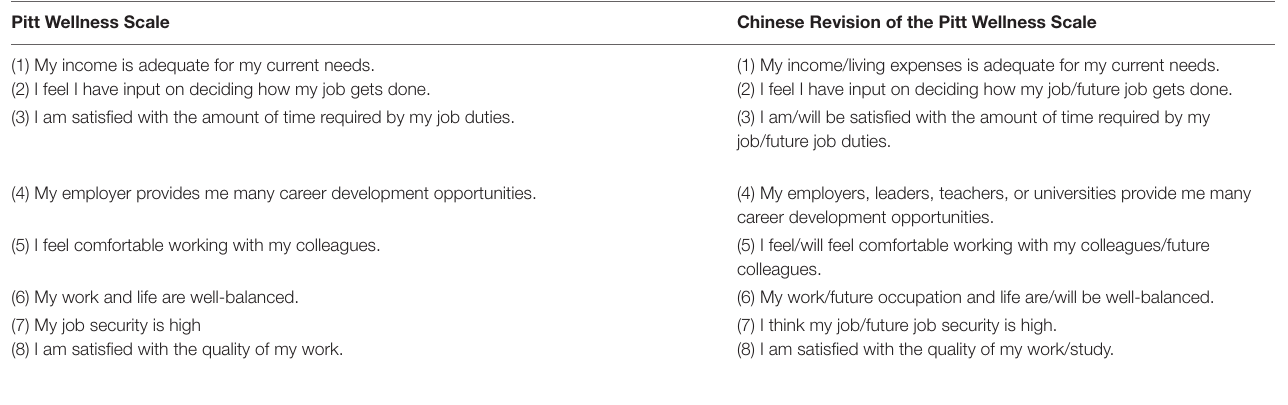
TABLE 1 | Modification items of Chinese Revision of the Pitt Wellness